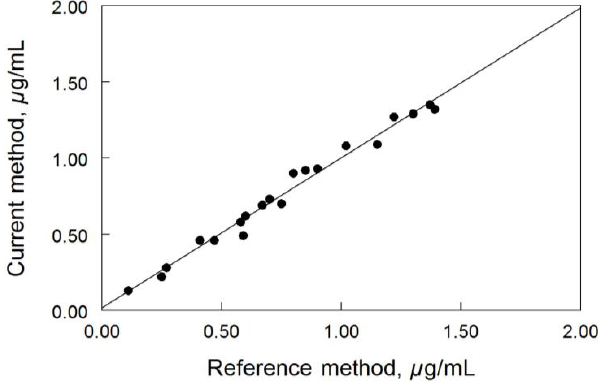
Figure 4. Cross-validation of posaconazole method ( n = 20).